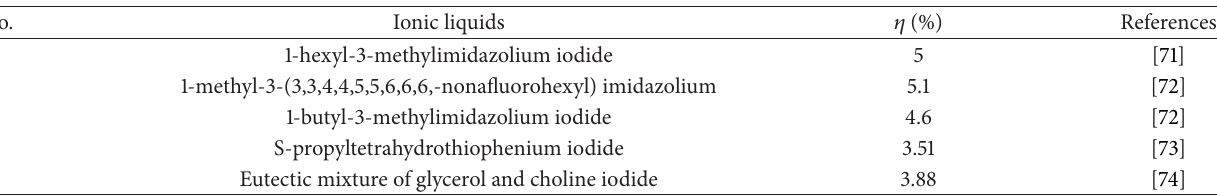
Table 4: ILs and their efficiencies in DSSC applications.